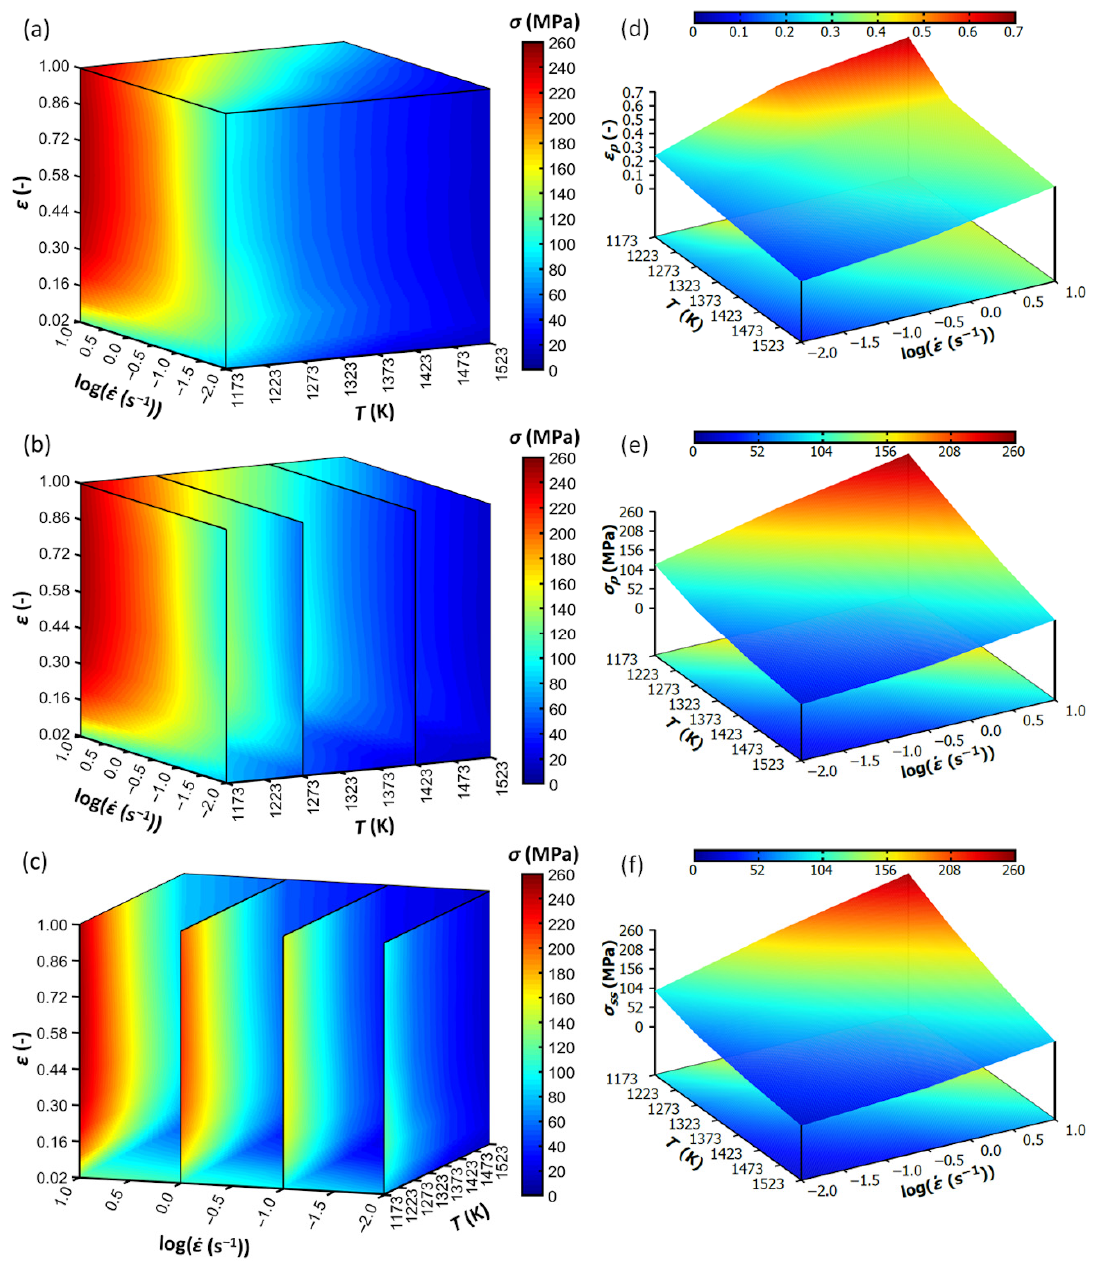
Figure 4. Volumetric and surface expression of the experimental dataset of the studied alloy. ( a ) Flow stress evolution: Global overview; ( b ) flow stress evolution: Temperature axis detail; ( c ) flow stress evolution: Strain rate axis detail; ( d ) peak strain evolution; ( e ) peak stress evolution; and ( f ) steady-state stress evolution.